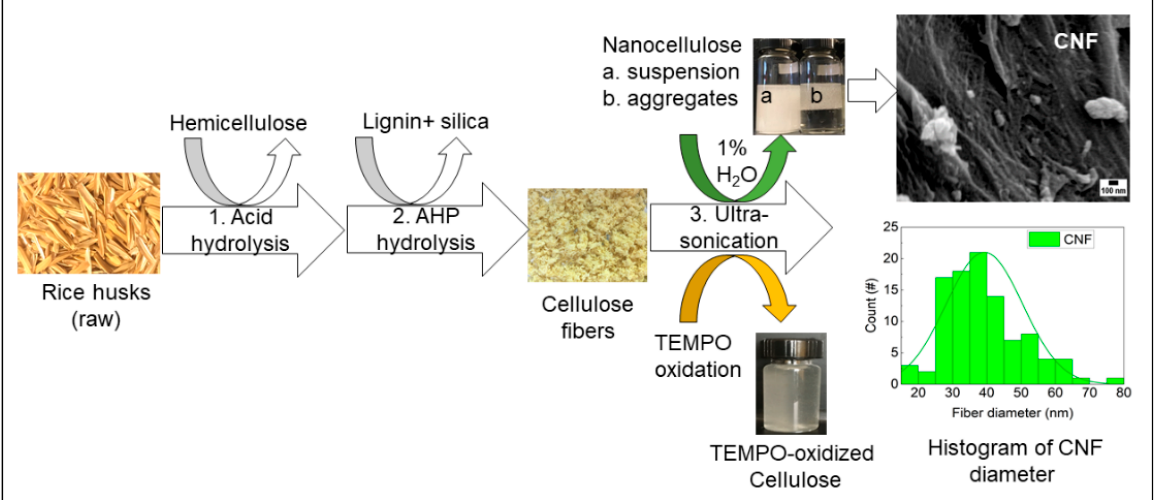
Figure 1. Fractionation of lignocellulose and silica from rice husks (RH). Extraction of cellulose nanofibers (CNF) and TEMPO-oxidized cellulose from rice husks using an ultrasonic-assisted method.